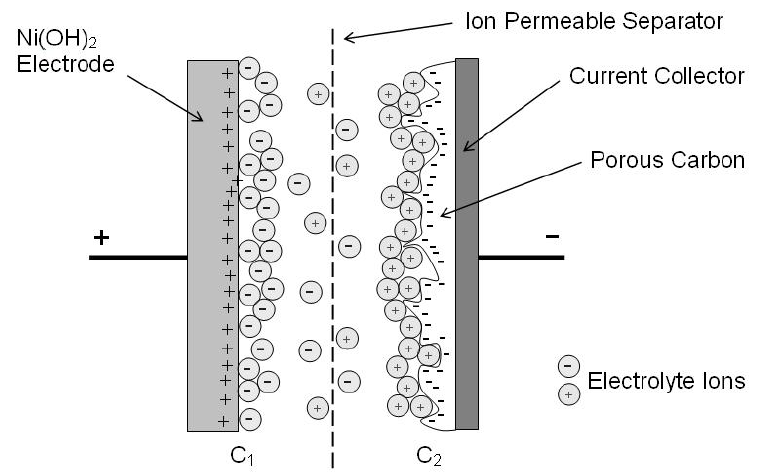
/NiOOH–porous carbon asymmetric supercapacitor 2